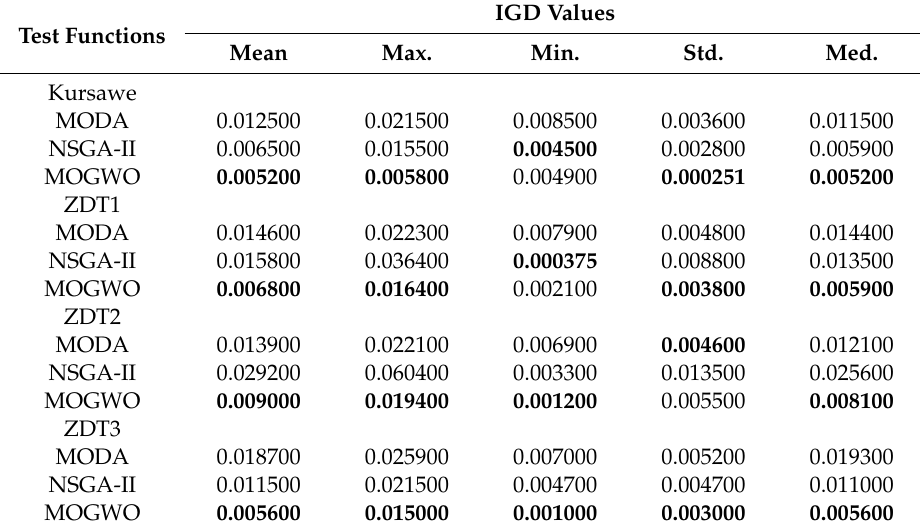
Table 5. Statistical values of the inverted generational distance (IGD) for four test